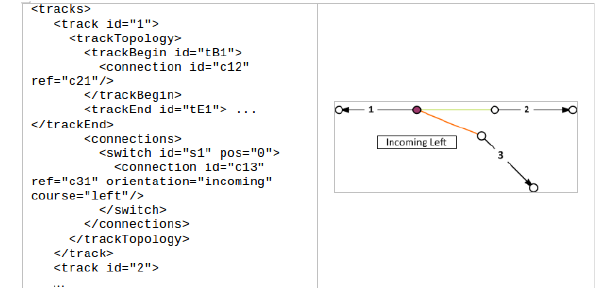
Figure 1. Description of connection using RailML 2.X (source [2]).